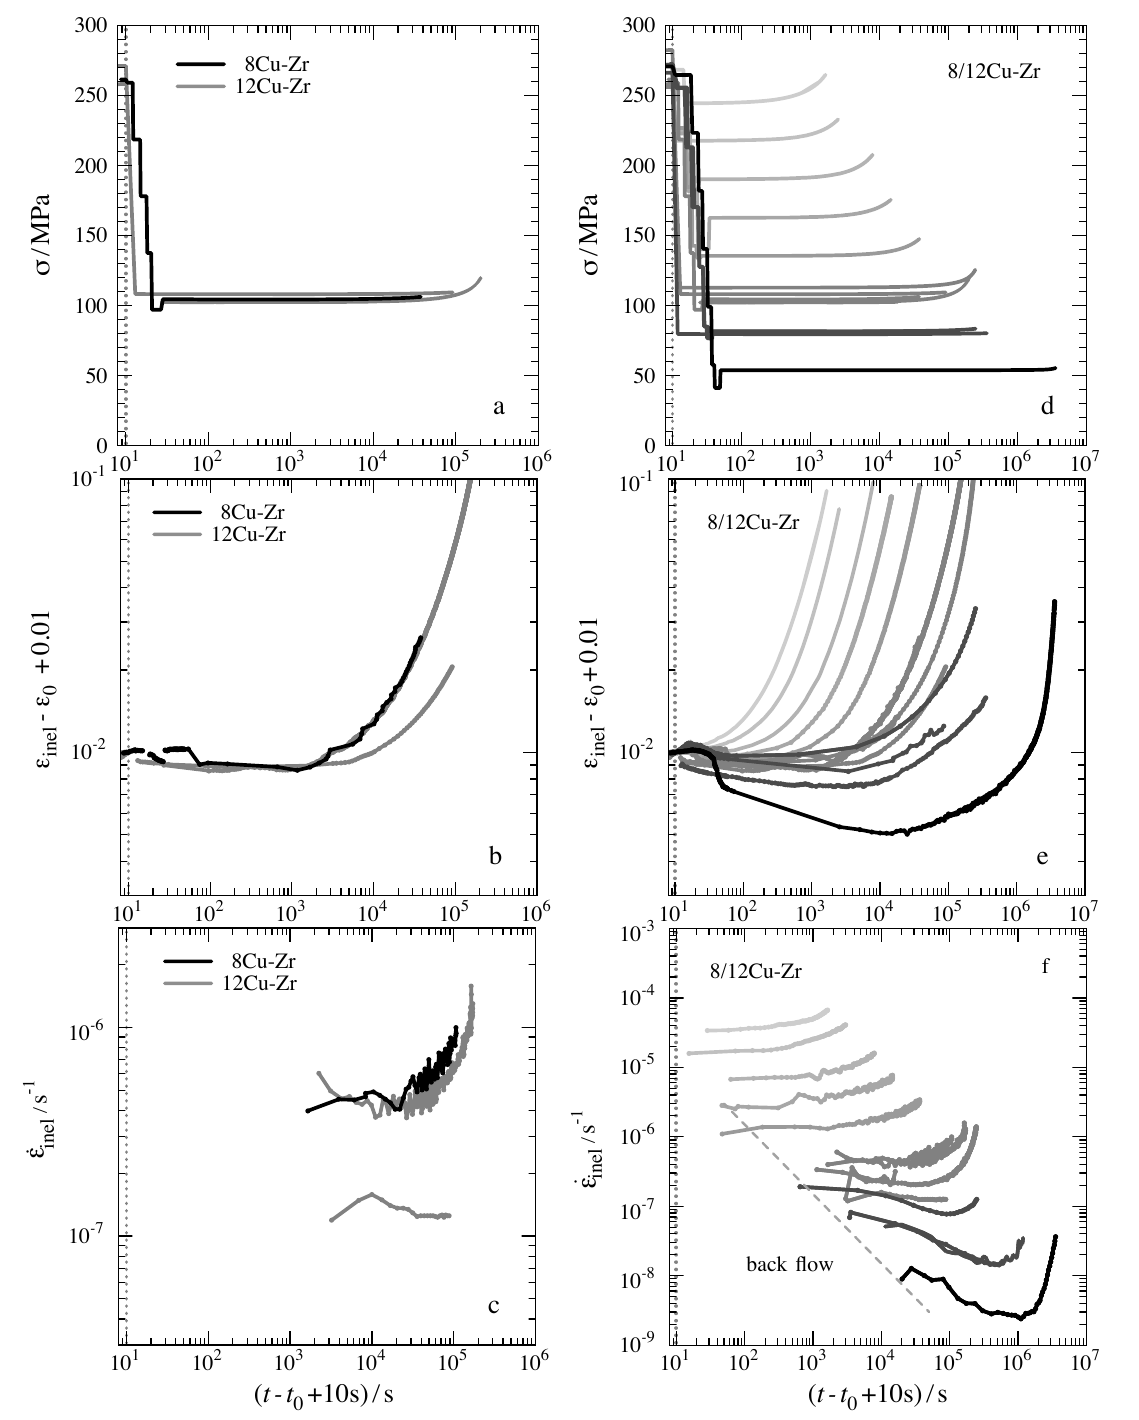
Figure 3. ( a ) Stress σ , ( b ) strain (cid:101) inel , and ( c ) strain rate ˙ (cid:101) inel as function of time t in tests for 8Cu–Zr and 12Cu–Zr with stepwise load reduction to ( a–c ) R = 0.4 and ( d–f ) all R ; dashed line in ( f ) approximates boundary of back